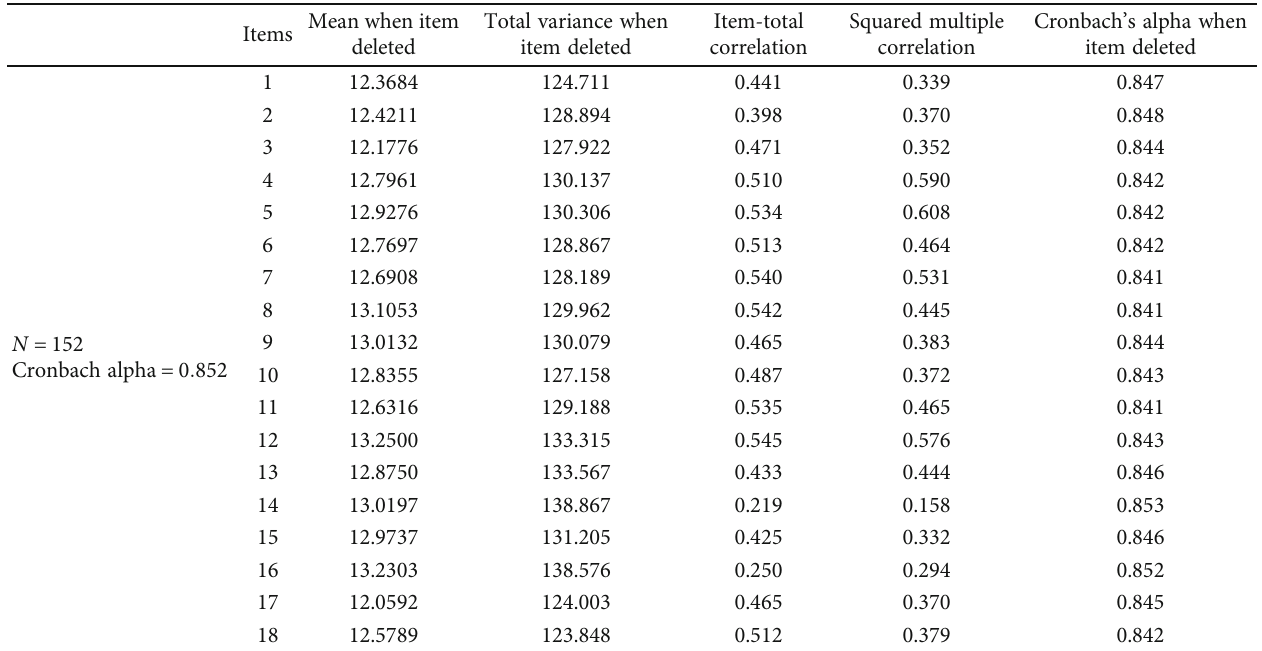
Table 2: Item-total